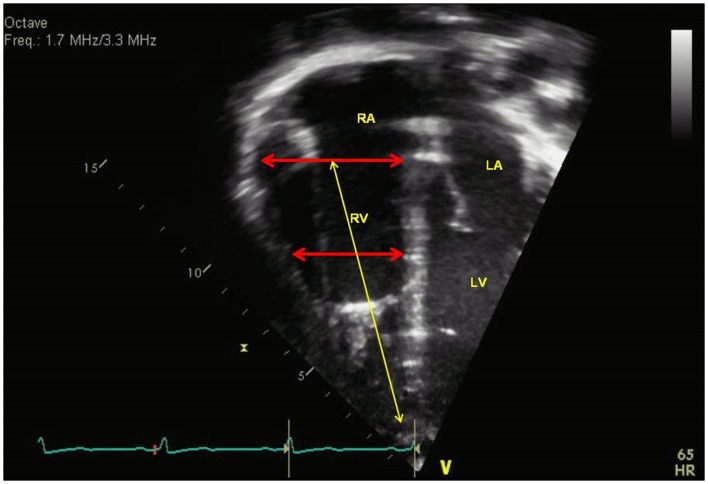
Measurement of right ventricular dimensions in end-diastole with basal dimension at the level of the tricuspid valve, the mid-cavity dimension (red arrows), and longitudinal dimension (yellow arrow). RA = right atria, RV = right ventricle, LA = left atria, LV = left ventricle.